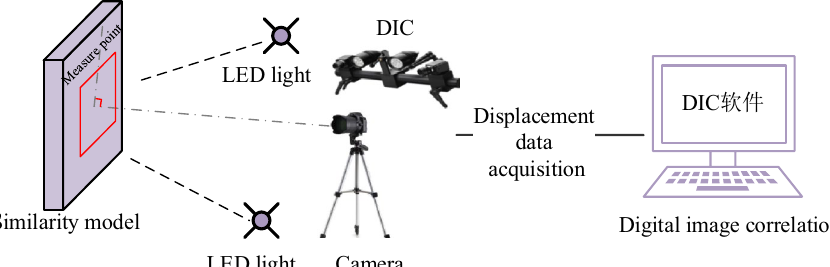
Figure 24. DIC measurement system.